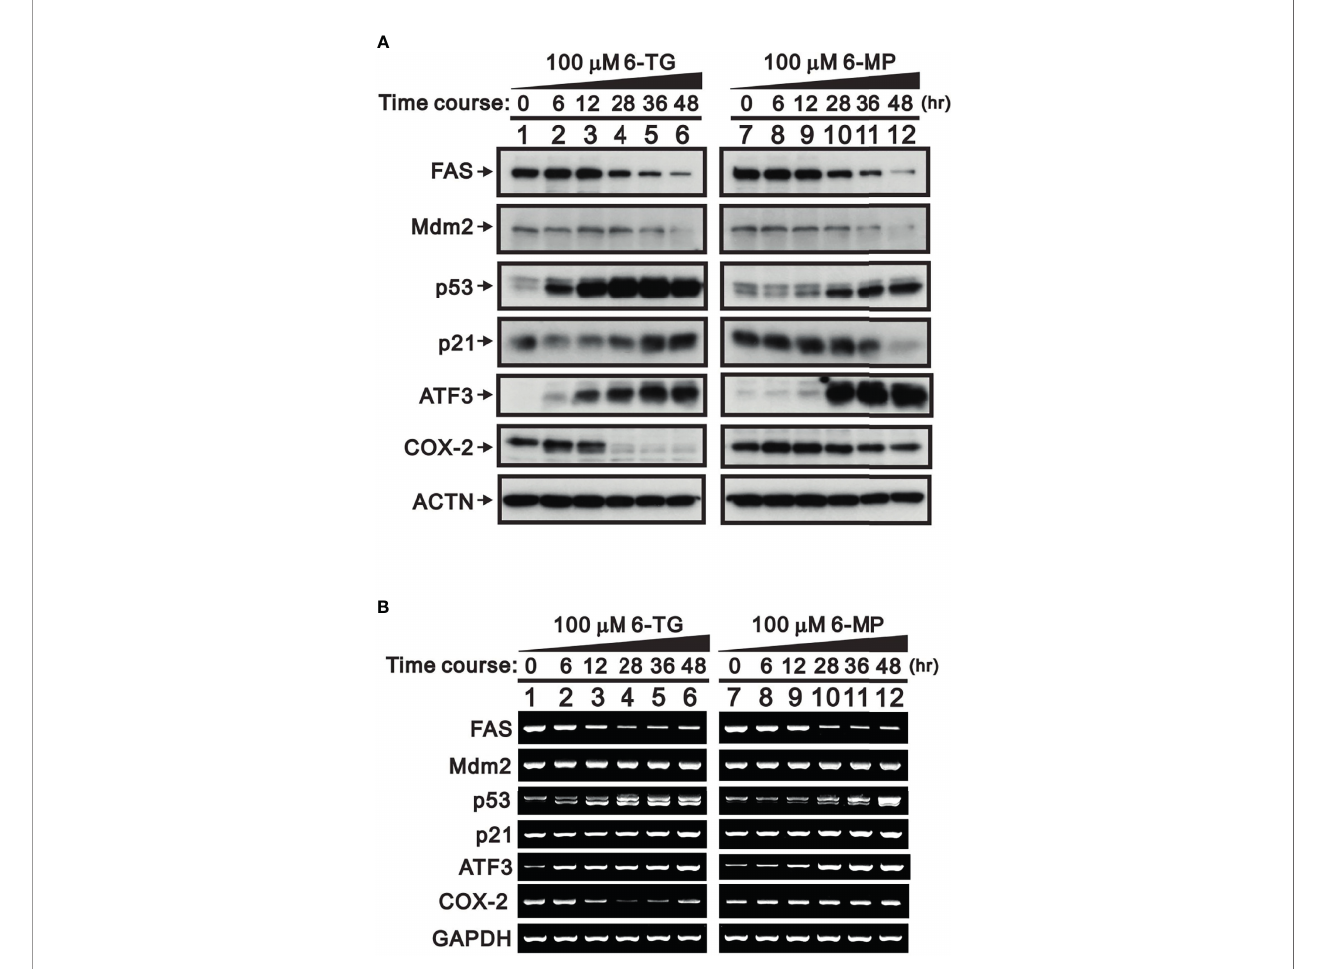
FIGURE 2 | Time-course of the effects of 6-TG and 6-MP in A253 cells. Cells were treated for the indicated times with vehicle or 100 m M 6-TG or 6-MP, after which cell lysates were subject to (A) Western blotting analysis with antibodies against FAS, Mdm2, p53, p21, ATF3, and COX-2; or (B) RT-PCR analysis for FAS, Mdm2, p53, p21, ATF3, and COX ‐ 2 mRNAs. ACTN is a protein loading control; GAPDH is an mRNA loading